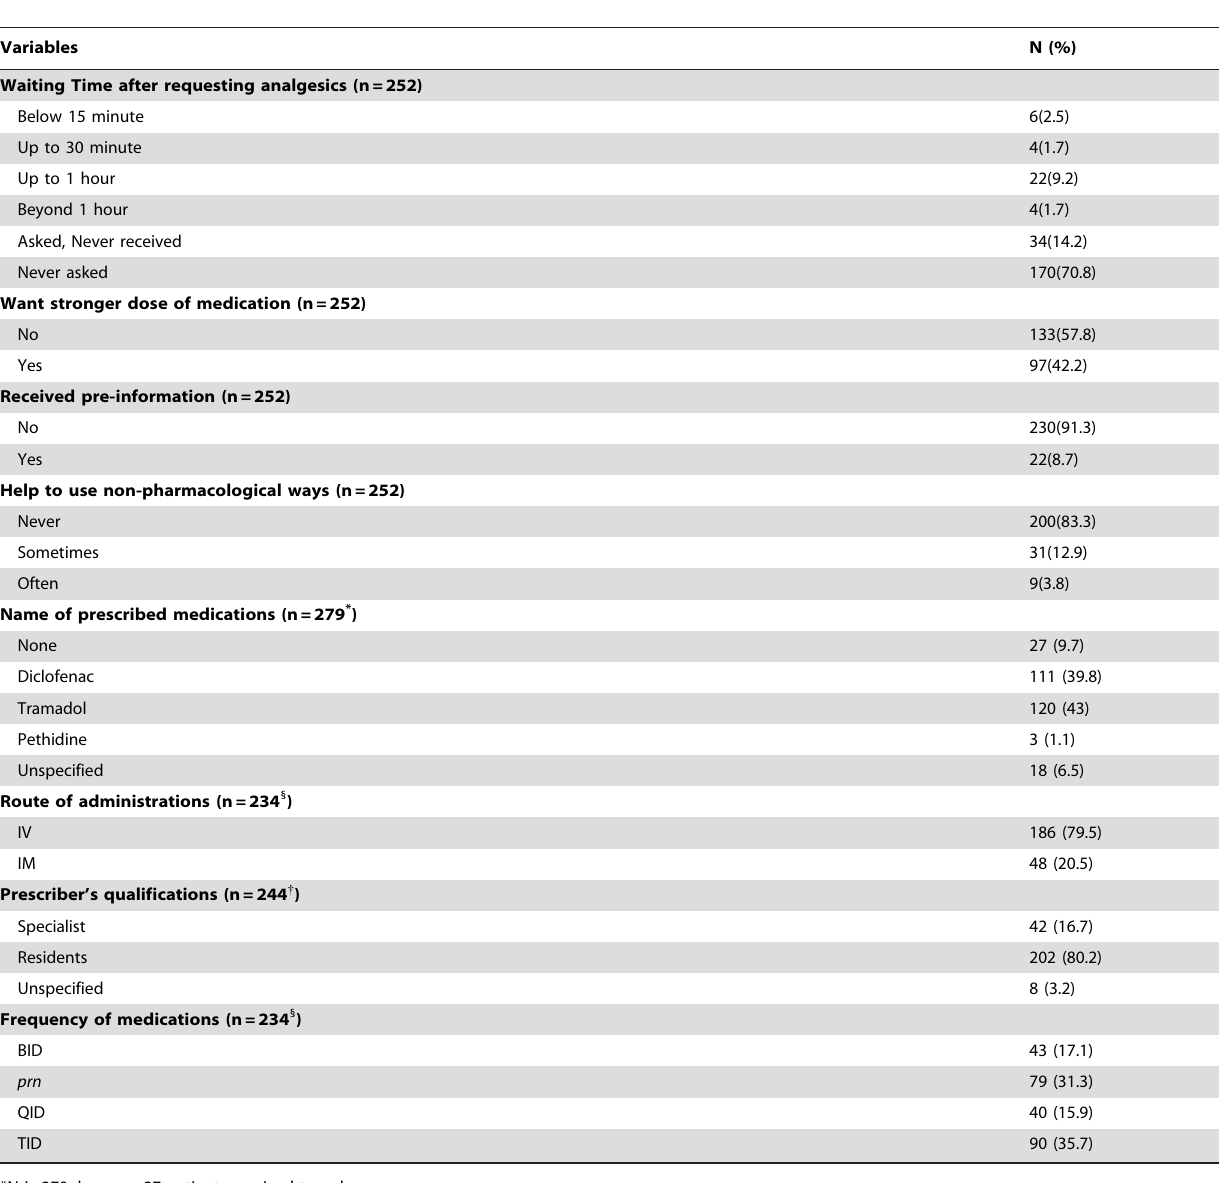
Table 3. Processes of pain management.